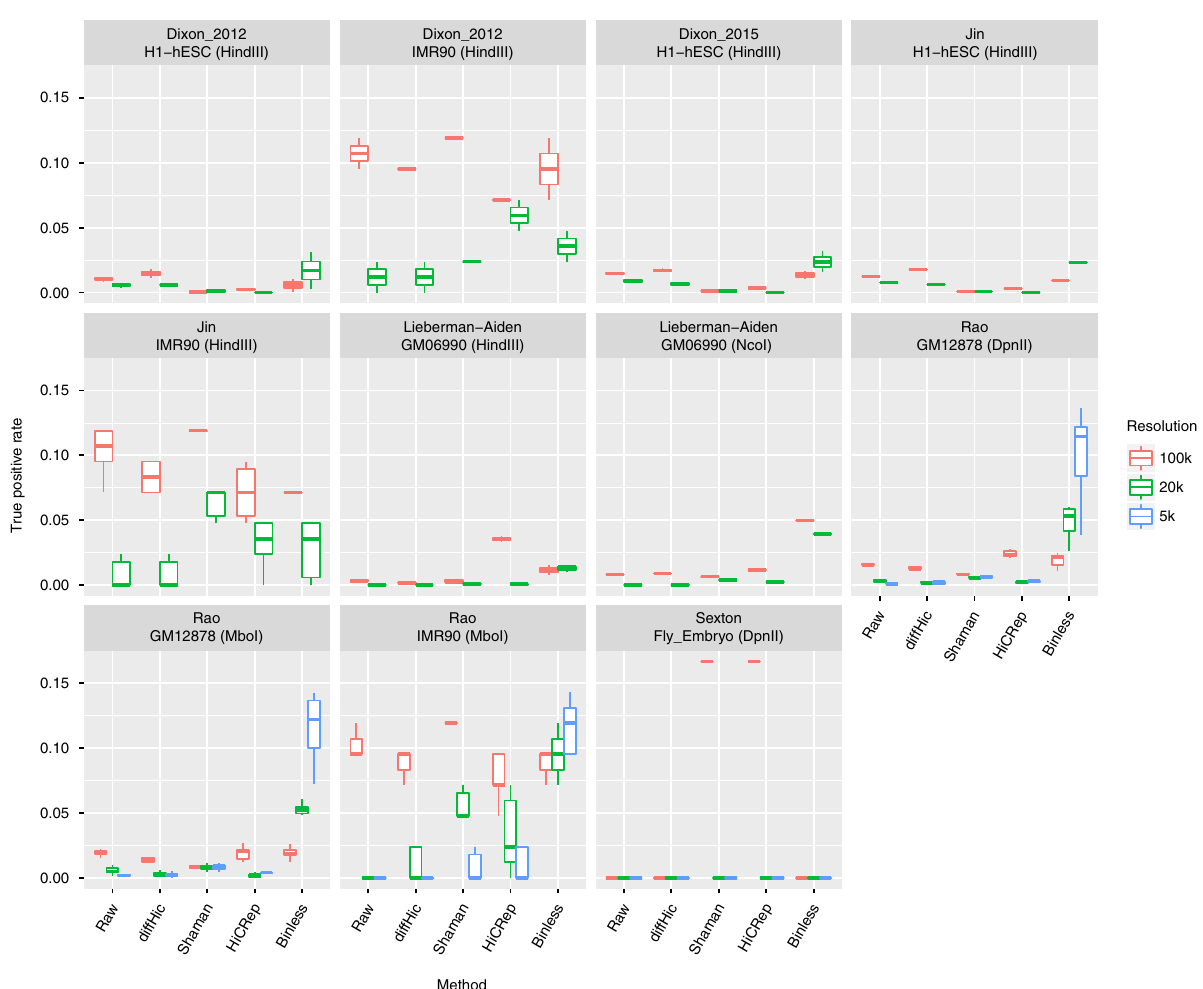
Fig. 3 Binless interaction detection has an improved true positive rate. Each box reports the true positive rate at several resolutions, for each interaction detection method. (see methods for details, and Sup. Table panel 9 for total number of annotated true